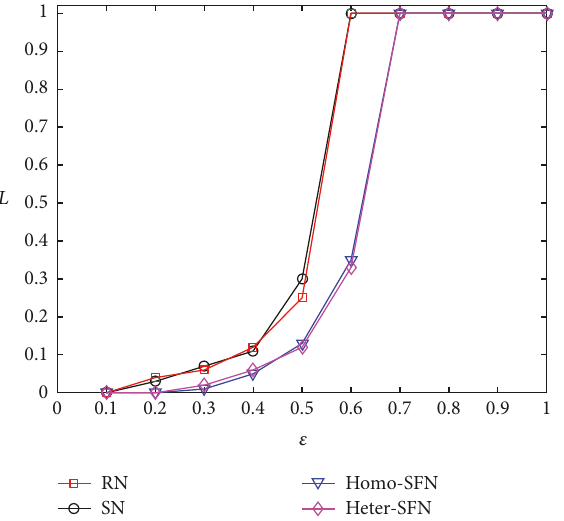
Figure 13: 𝐿 - 𝜀 relation curve under max-status attack (𝑅 = 1) .